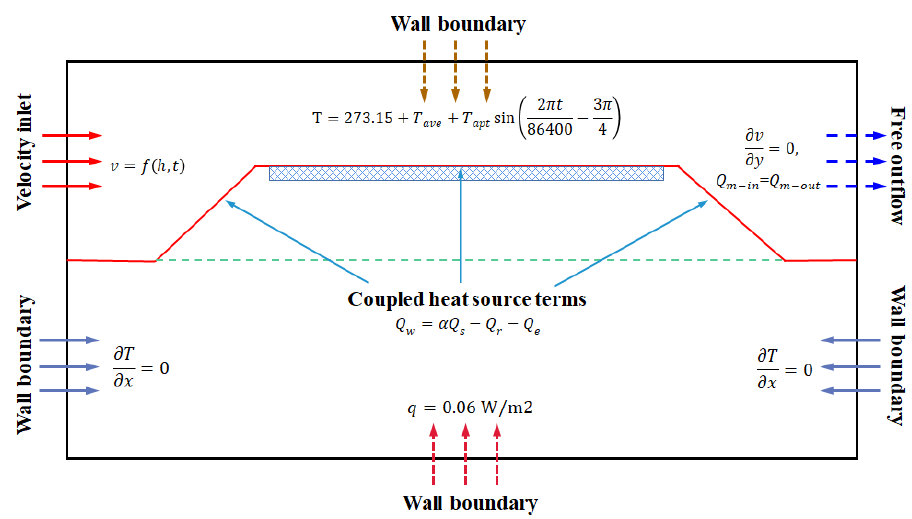
Figure 5. Schematic diagram of the boundary conditions.